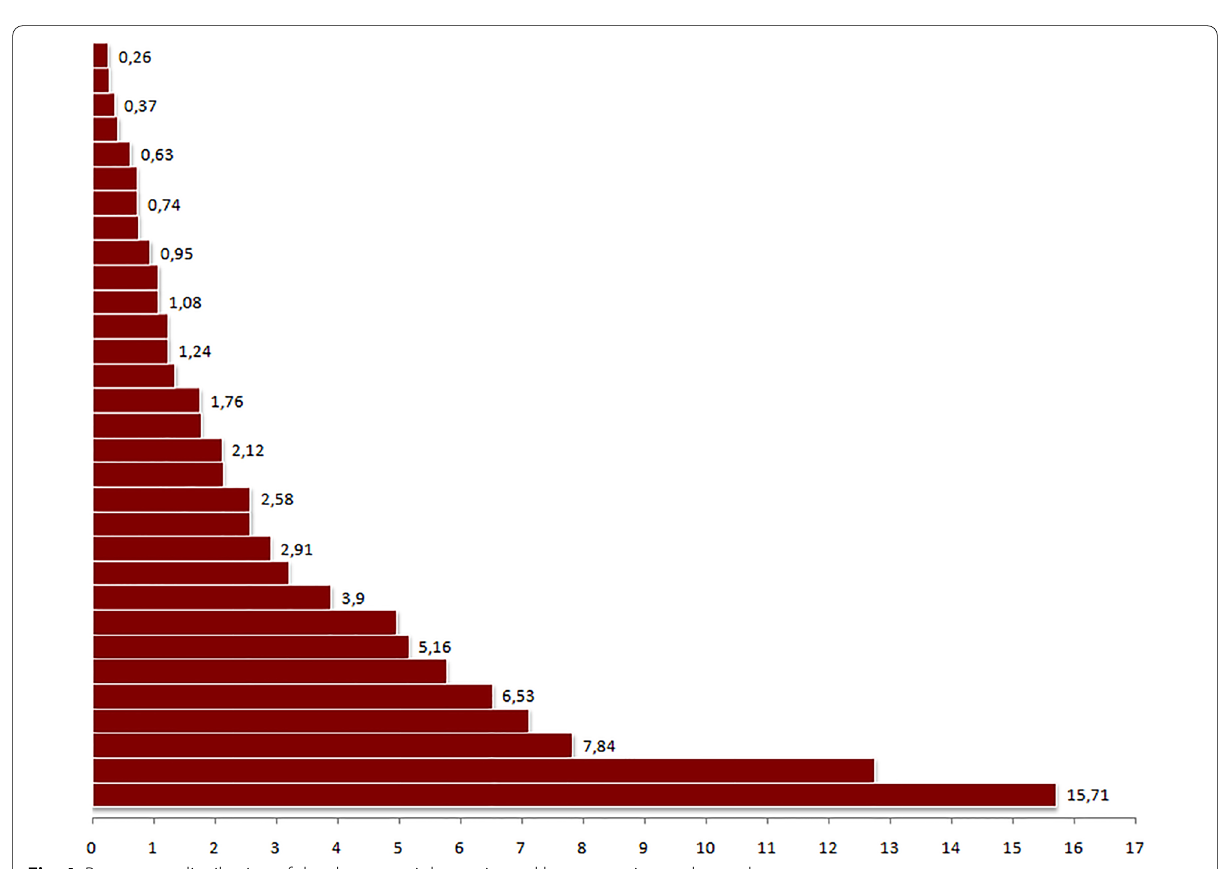
Fig. 4 Percentage distribution of development rights registered by companies on the